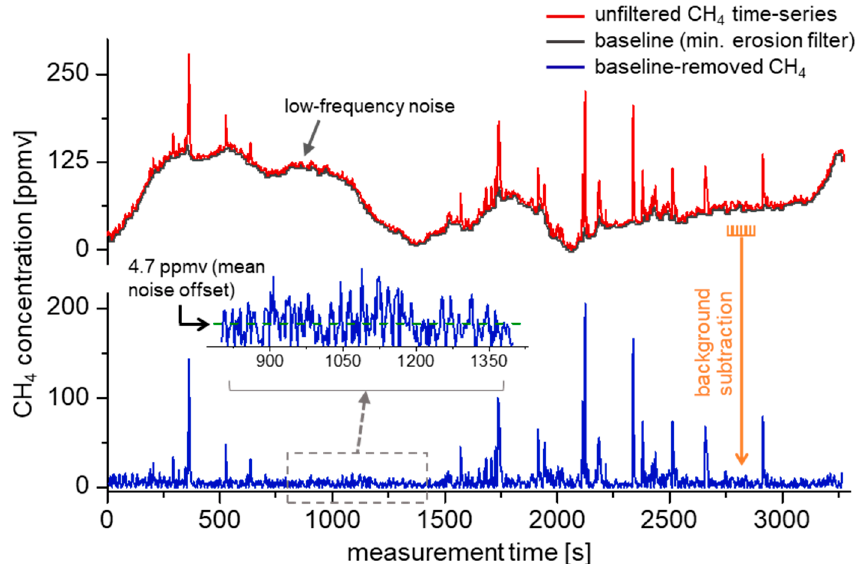
Figure 5. Removal of the TDLAS sensor baseline via local minimum erosion [39]. Concentration drifts are primarily due to spectral baseline fluctuations in the presence of large ambient temperature variations. The erosion filter is applied at 20 s intervals to identify and null the background (black curve). A side effect of this method involves the presence of a baseline offset (inset), which is removed via peak thresholding prior to AOA determination.